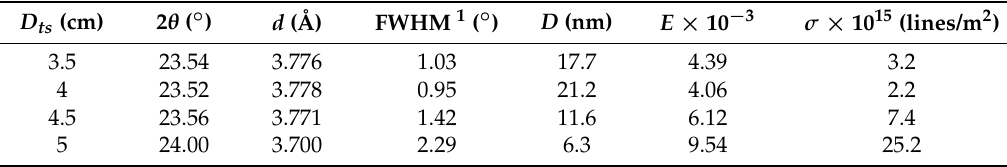
Figure 3. X-ray diffraction (XRD) analysis of CdTe films deposited at different substrate-target distances. ( a ) XRD patterns, and ( b ) comparison of the main peak for all samples. Table 2. Crystal parameters of CdTe films prepared at different substrate-target distances, D ts